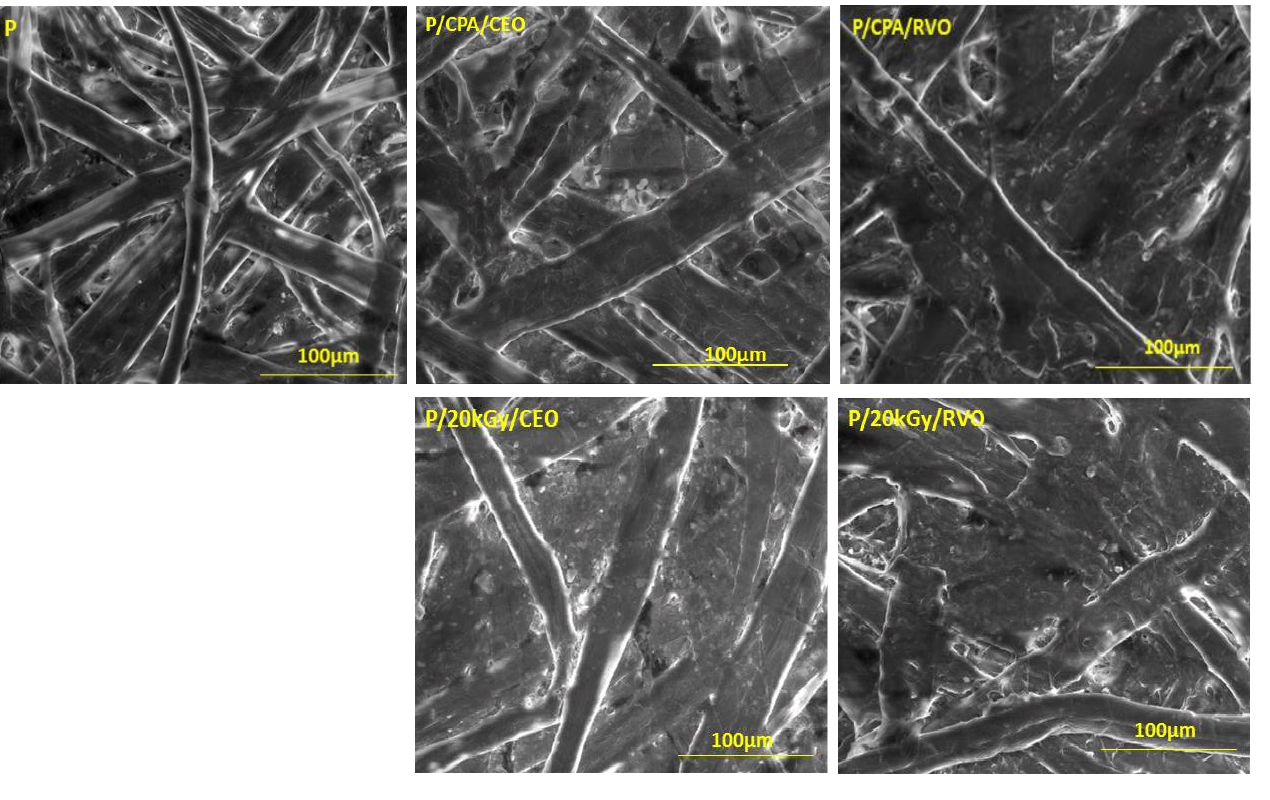
Table 2. EDAX data expressed in weight (wt) and atomic (At) manner for kraft paper treated with plant oils in comparison with the unmodified one.